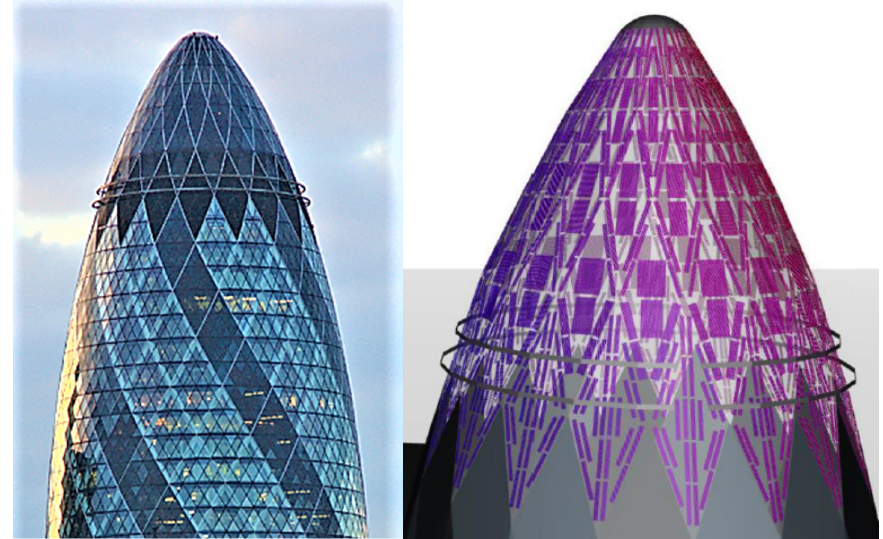
Figure 7. “The Gherkin” London, UK [46] and the BIPV modules designed for this building [45].